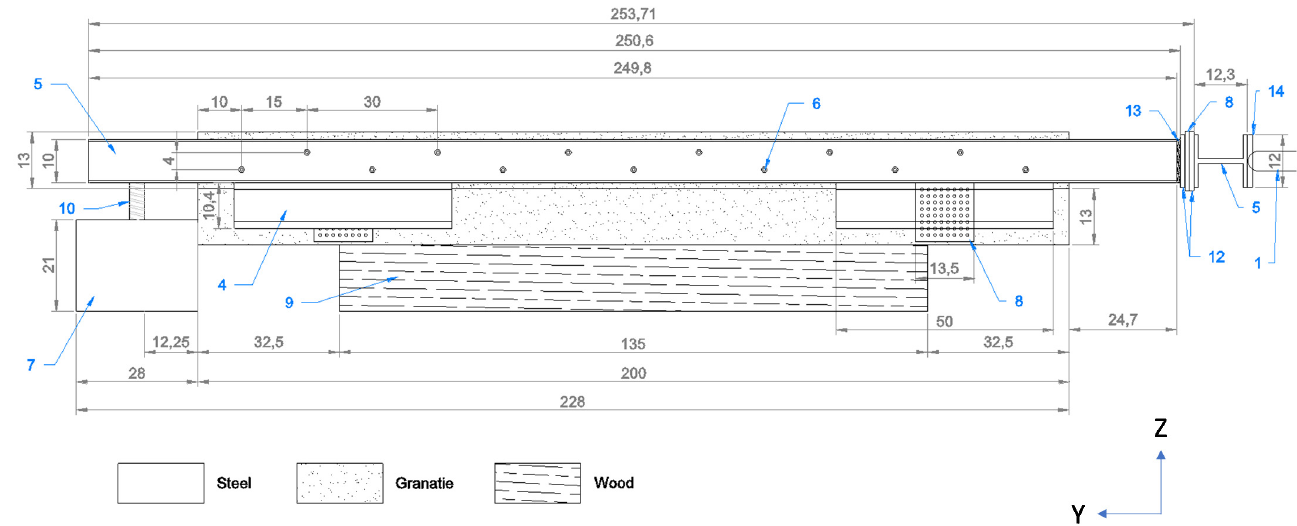
Figure A1. Side view of the experimental setup. Dimensions in centimeters [cm].